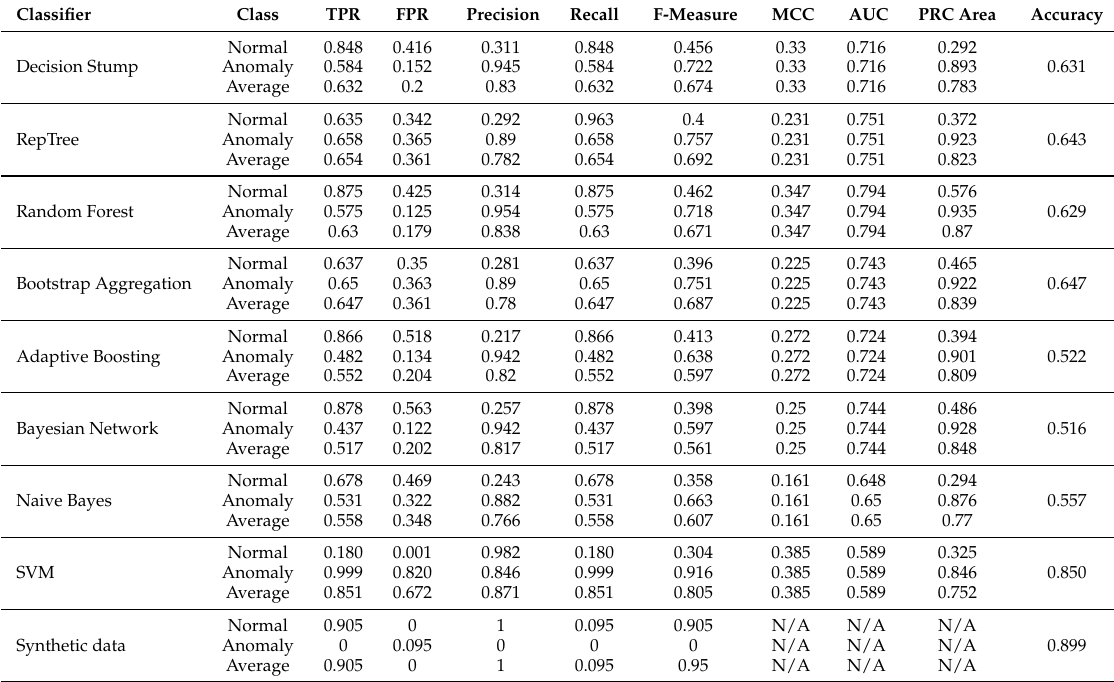
Table 10. Results when analyzing NSL-KDD’99 − 21